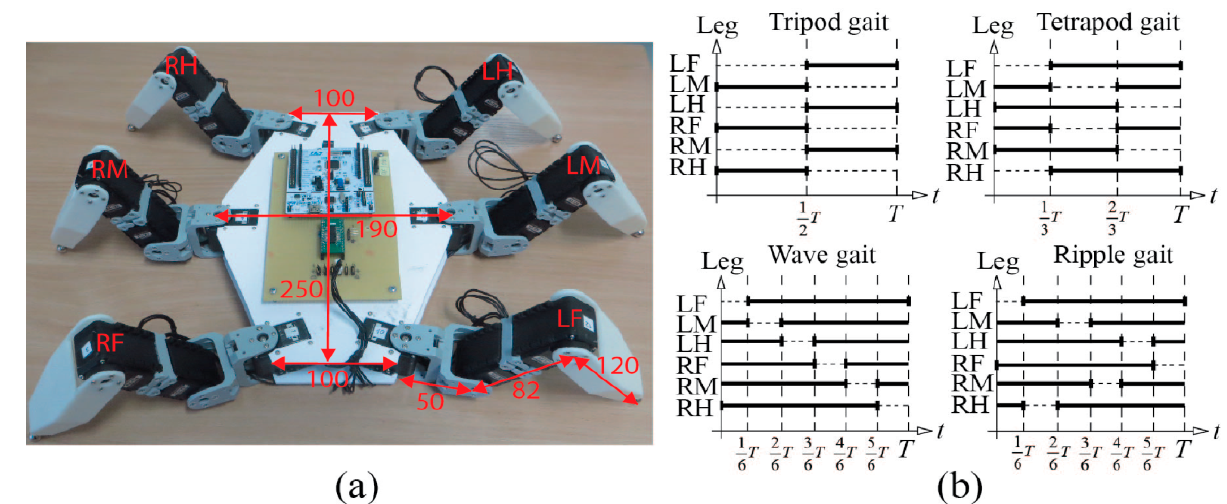
Figure 1. Hexapod robot model HexaV4 ( a ) and gait used in experiments time diagrams (black lines represent leg’s support phase, dashed gap—transfer phase) ( b ). Leg abbreviations: LF—left front; LM—left middle; LH—left hind; RF—right front; RM—right middle; RH—right hind; T—gait period. All dimensions are in millimeters.